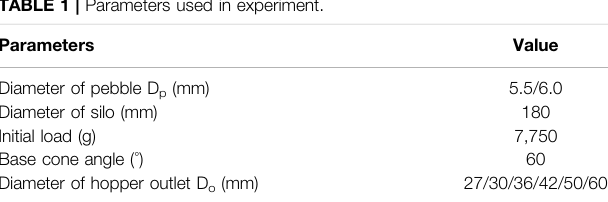
TABLE 1 | Parameters used in experiment.